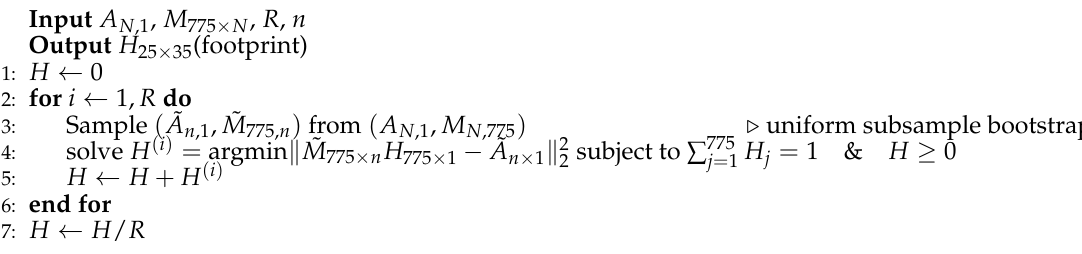
Algorithm 1 Advanced microwave scanning radiometer-Earth observing satellite (EOS) (AMSR-E) footprint